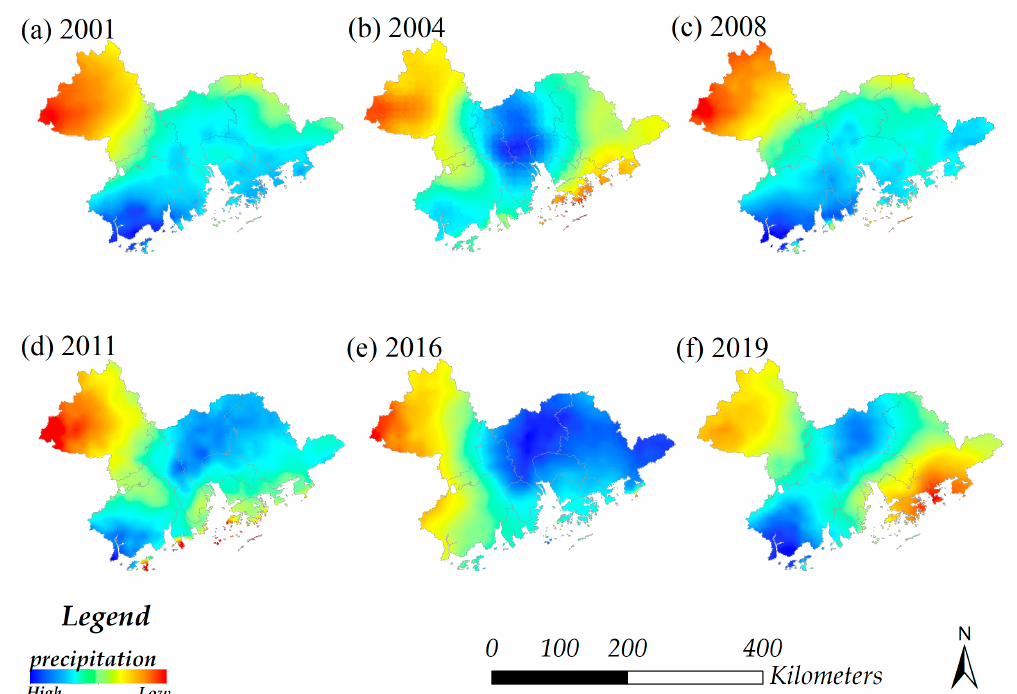
Figure 8. Spatial distribution of precipitation in the GBA, 2001–2019.